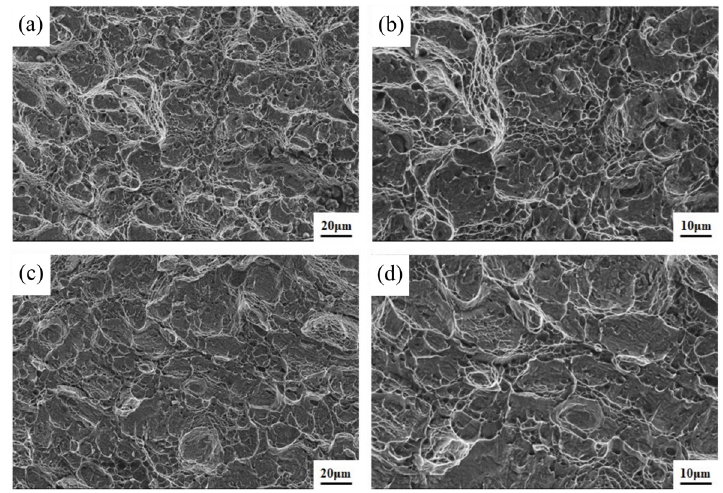
Figure 16. Impact fracture morphology comparison of flux-cored wire and cable wire welding joints: ( a , b ) flux-cored wire welding joint; ( c , d ) cable wire welding joint.